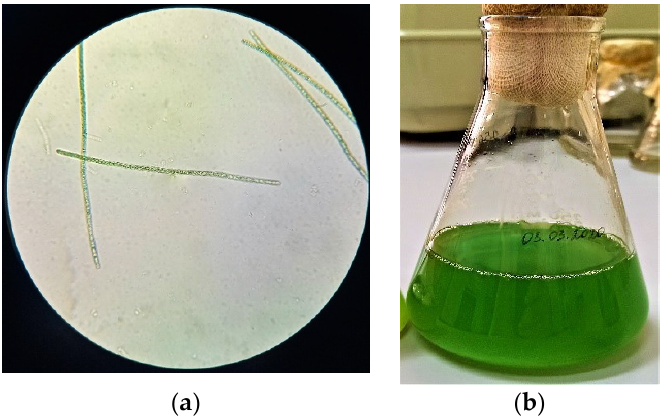
Figure 2. The results of studying the morphological features of the microalgae Arthrospira platensis and their suspensions: ( a ) Cells under a microscope; ( b ) The suspension’s appearance.